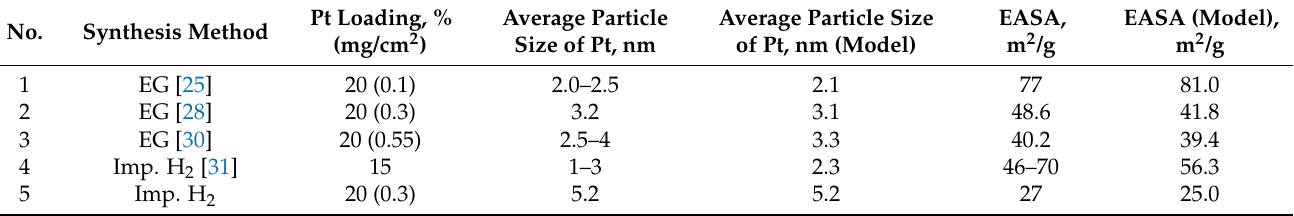
Table 2. Structural and electrochemical characteristics of electrocatalysts, where EG represents a reduction in ethylene glycol, and H 2 represents an impregnation of CL with the precursor and subsequent reduction of platinum with hydrogen.